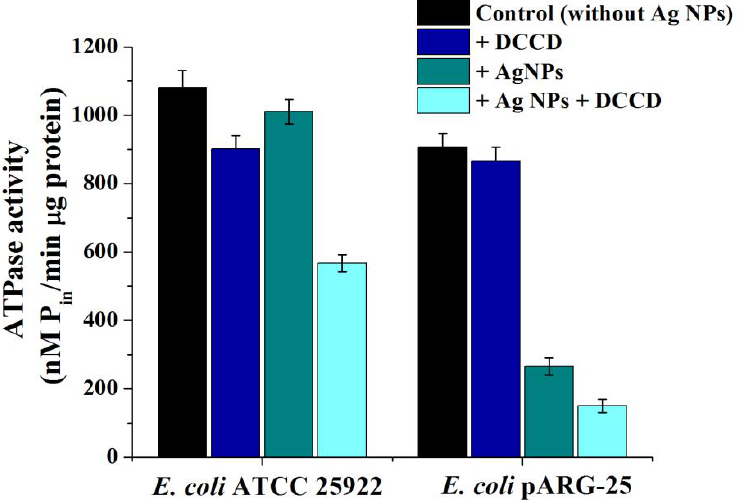
Figure 6. The impact of biogenic Ag NPs on ATPase activity of E. coli ATCC 25922 and kanamycin- resistant E. coli pARG-25 membrane